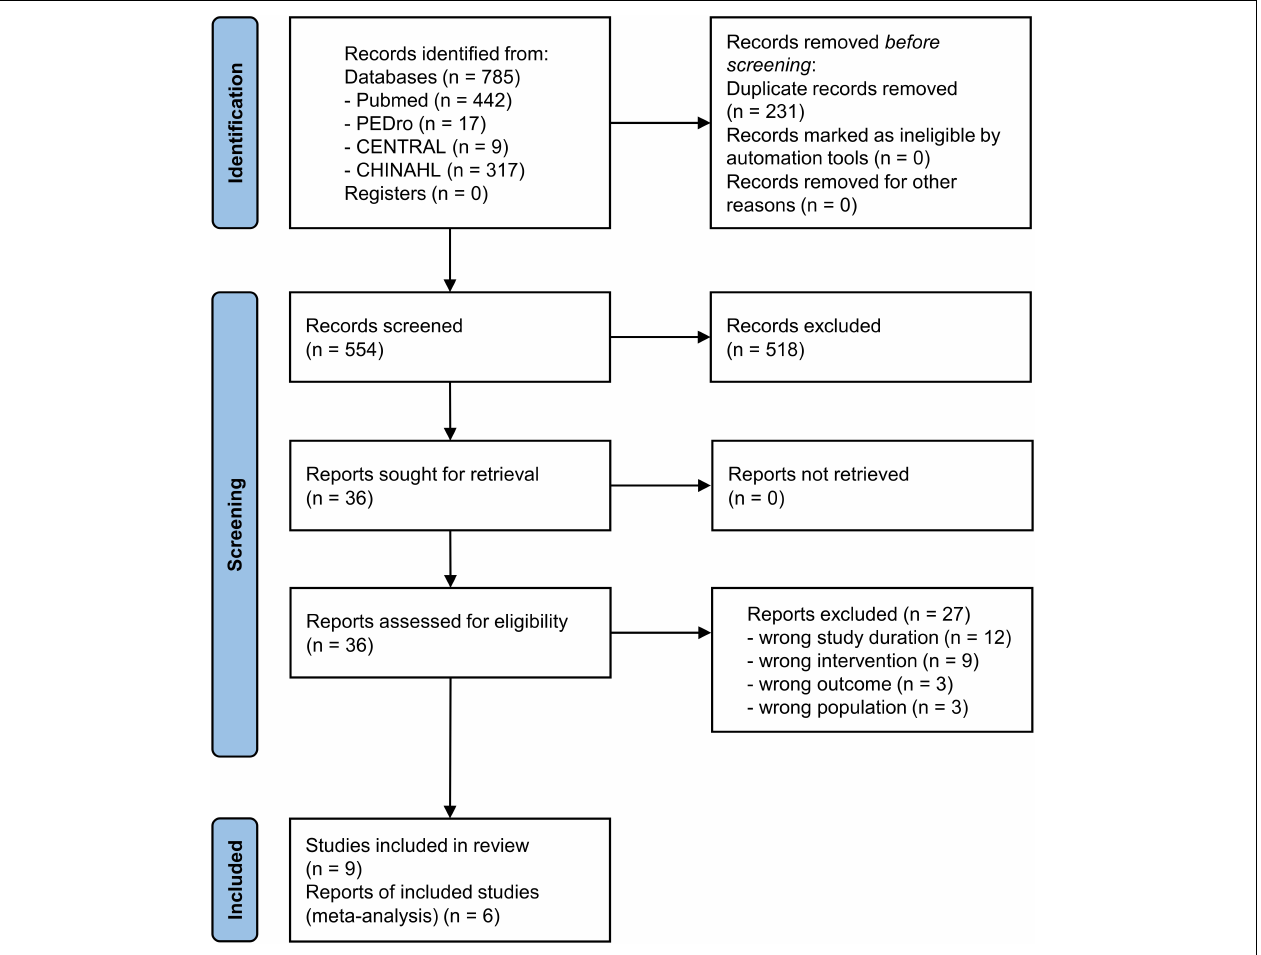
FIGURE 1 | Flow diagram of the study selection